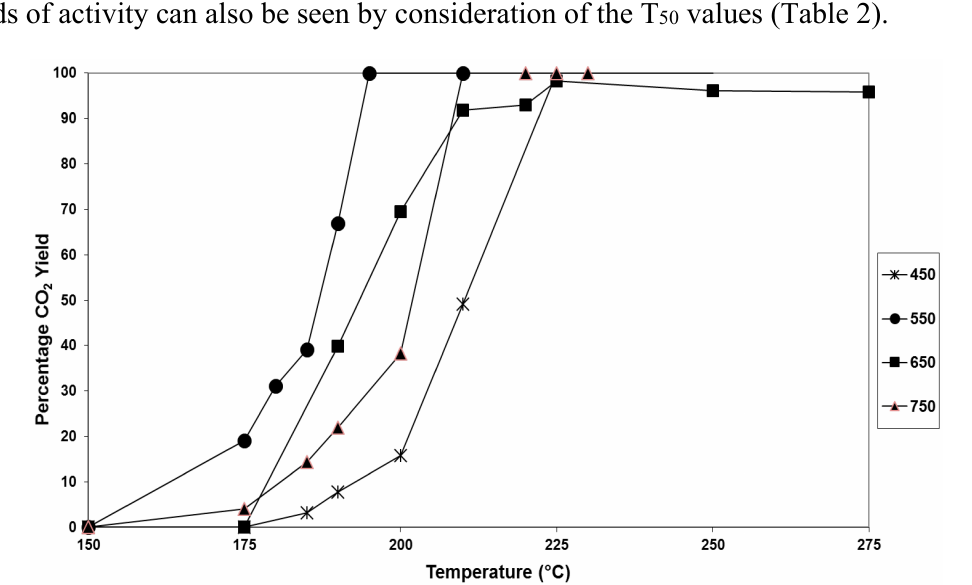
Figure 2. Steady-state conversion of naphthalene to CO 2 as a function of temperature for a 2.5 wt.% Pt/SiO 2 catalyst prepared at varying calcination temperatures:  450 °C; ● 550 °C; ■ 650 °C; ▲ 750 °C. Table 2. Summary of characterisation data and naphthalene oxidation performance